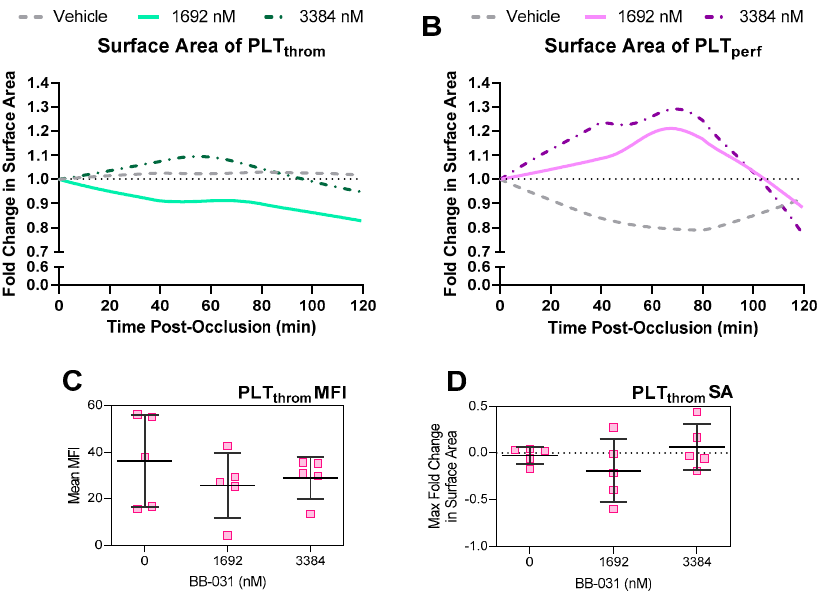
Figure 6. Platelets involved in initial thrombus formation were labeled with a fluorophore excited by an ultraviolet (UV) wavelength (350 nm, PLT throm ), platelets in the treated reperfusion sample were labelled with a fluorophore excited by a near far red wavelength (646 nm, PLT perf ). Surface area was determined using fluorescence microscopy images in post processing using a thresholding function. Reperfusion samples were treated with either vehicle, 1692 nM BB-031, or 3384 nM BB-031. Data are shown as traces representing mean Loess curves of N = 5 experiments. ( A ) Fold change in surface area of PLT throm during reperfusion. ( B ) Fold change in surface area of PLT perf during reperfusion. Quantitative microfluidic parameters describing thrombolytic efficacy were also derived. ( C ) Mean PLT throm mean fluorescence intensity (MFI), used in correlation analysis as a measure of microfluidic lytic efficacy (MLE). N = 5. ( D ) Maximum fold change in PLT throm surface area (SA). Individual data points are shown in ( C , D ). Error bars represent mean ± standard deviation (SD).